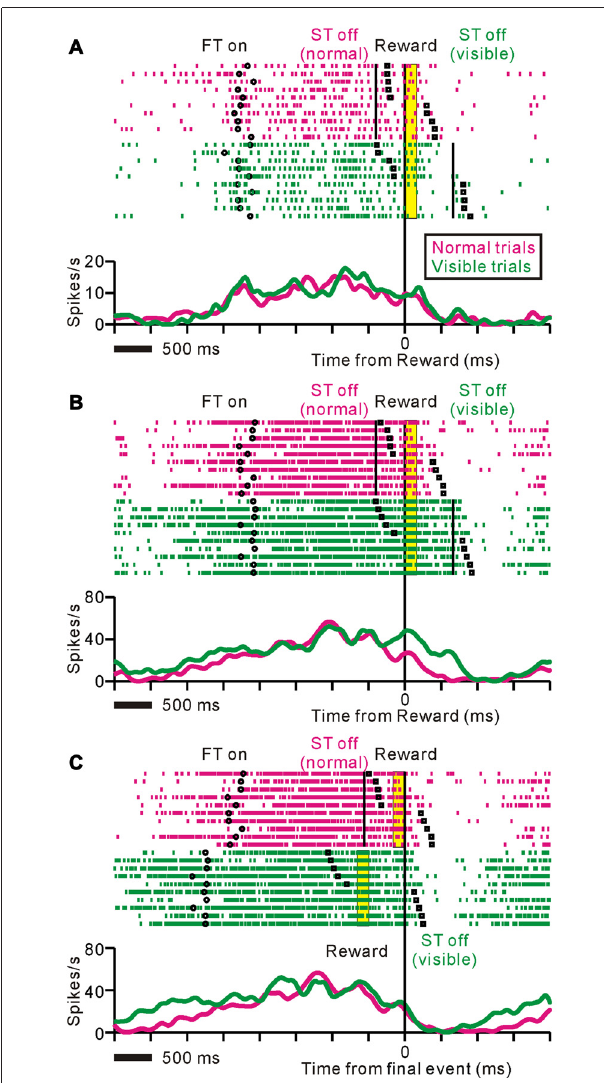
FIGURE 4 | Examples of neuronal activities during normal (magenta) and visible (green) task conditions displayed as rastergrams ( upper ) and spike density functions ( lower ). The black circles indicate appearance of the fixation target (FT), black solid lines indicate disappearance of the ST, black squares indicate fixation break, and yellow bars indicate reward delivery period. The trials are sorted by fixation break timing relative to reward delivery. (A) This representative neuron showed almost identical responses during the normal and visible task conditions. The data are aligned to the time of reward delivery. (B,C) Examples of neuronal activity during the same set of trials are shown. The data are aligned to the time of reward delivery (B) and the end of an individual trial (C) . In the visible condition, tonic responses were sustained until the disappearance of the ST after the reward delivery.